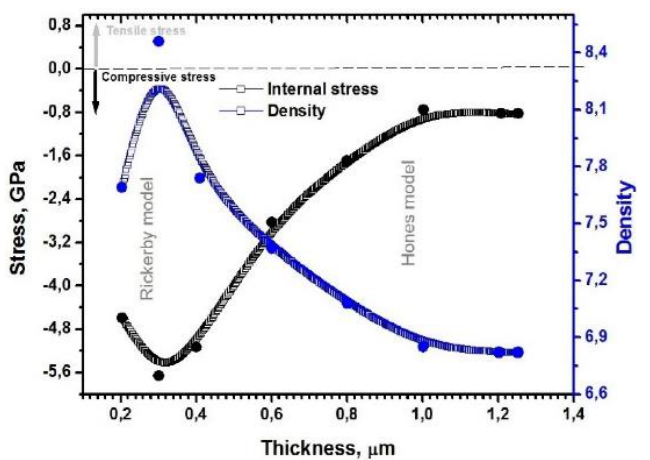
Fig. 8. Variation of the internal stress and density as a function of MoN film